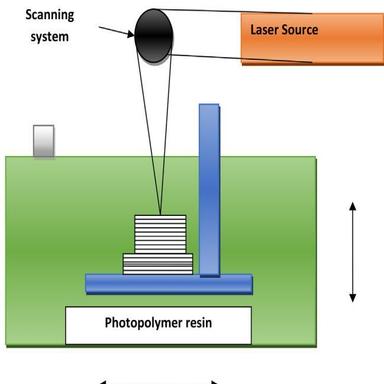
Simple line diagram of stereolithography.